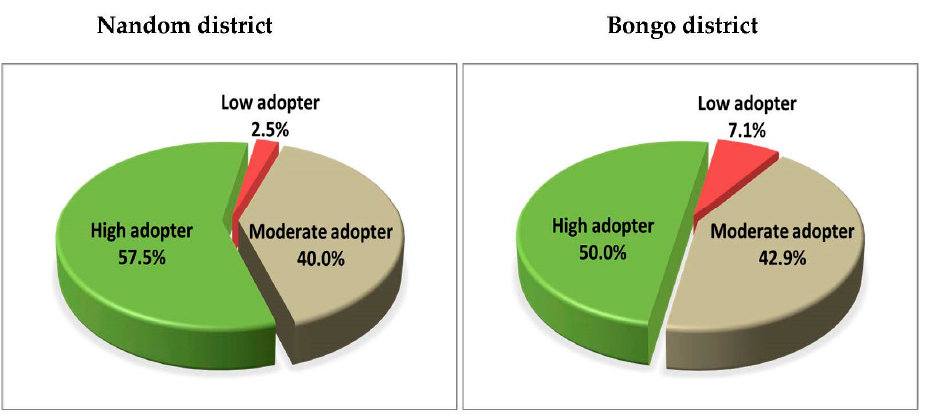
Figure 3. Rate of adoption of CSA practices in the districts.